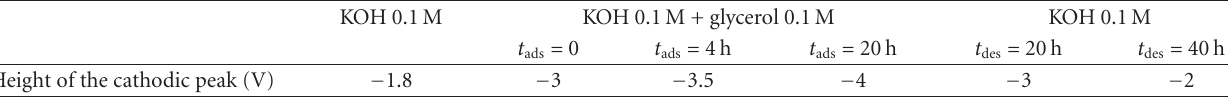
Table 4: Heights of the cathodic peak observed at − 1 V as a function of the adsorption ( t ads ) and desorption ( t des ) times. KOH 0.1 M Height of the cathodic peak (V) − 1.8 − 2